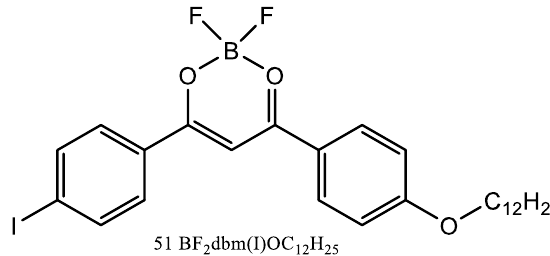
Figure 11. Structure of BF 2 dbmOC 12 H 25 .